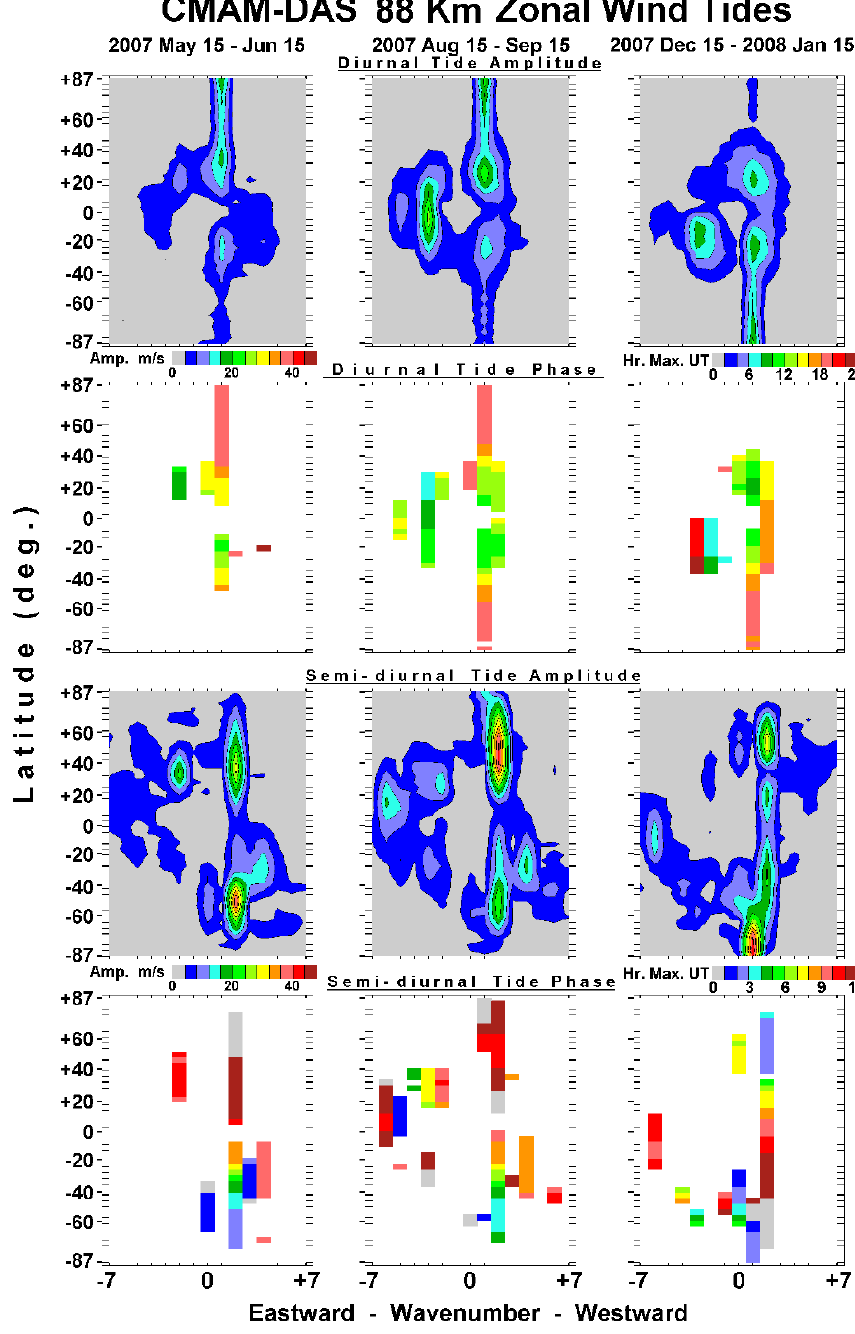
Fig. 10. Contour-plots of amplitudes and phases of the zonal wind diurnal and semidiurnal tides as functions of wave-number (positive for westward propagation) and latitude (positive for Northern Hemisphere): data for near the summer and winter solstices along with the boreal autumn for the model CMAM-DAS have been used, and the results for 88km are shown. Phase is the hour of maximum (UT) at the Greenwich Meridian. For clarity, a phase value is just shown when its corresponding amplitude is above an arbitrary